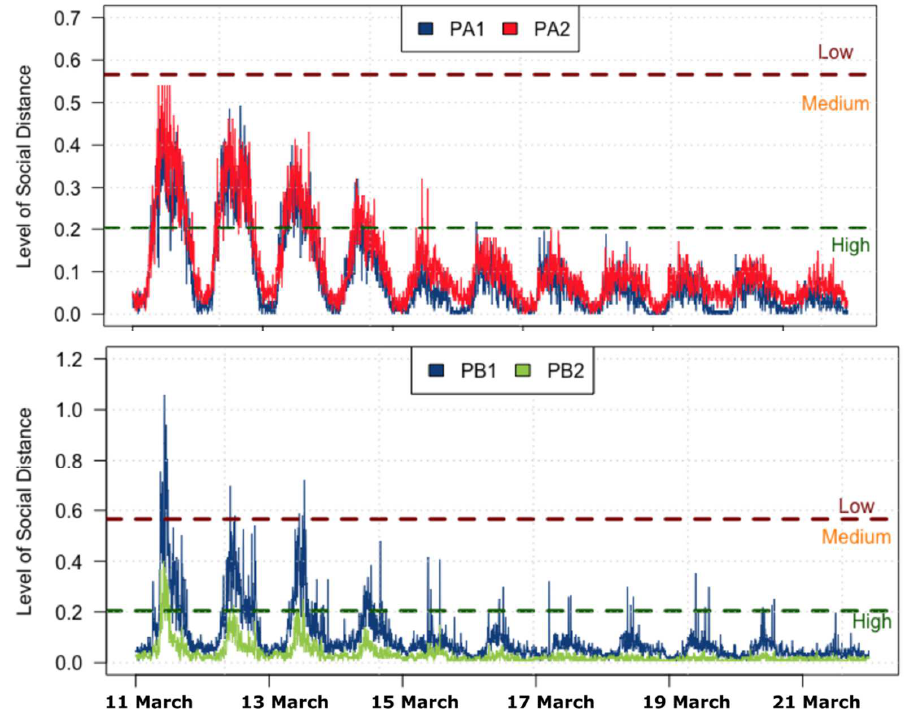
Figure 9. LoSD evolution in study areas during the week that includes the start date of lockdown in Spain (14 March